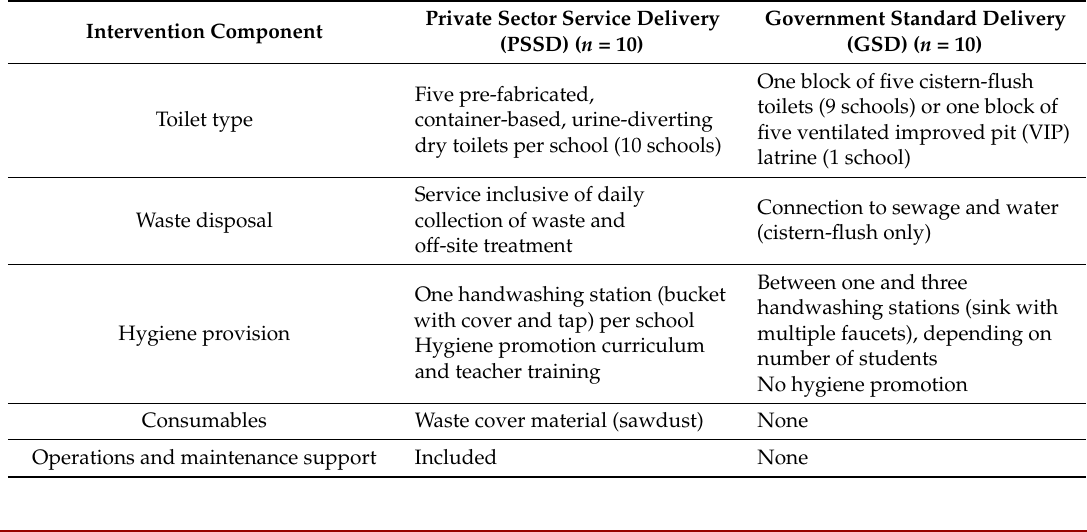
Table 1. Comparison of Private Sector Service Delivery (PSSD) and Government Standard Delivery (GSD) intervention components.